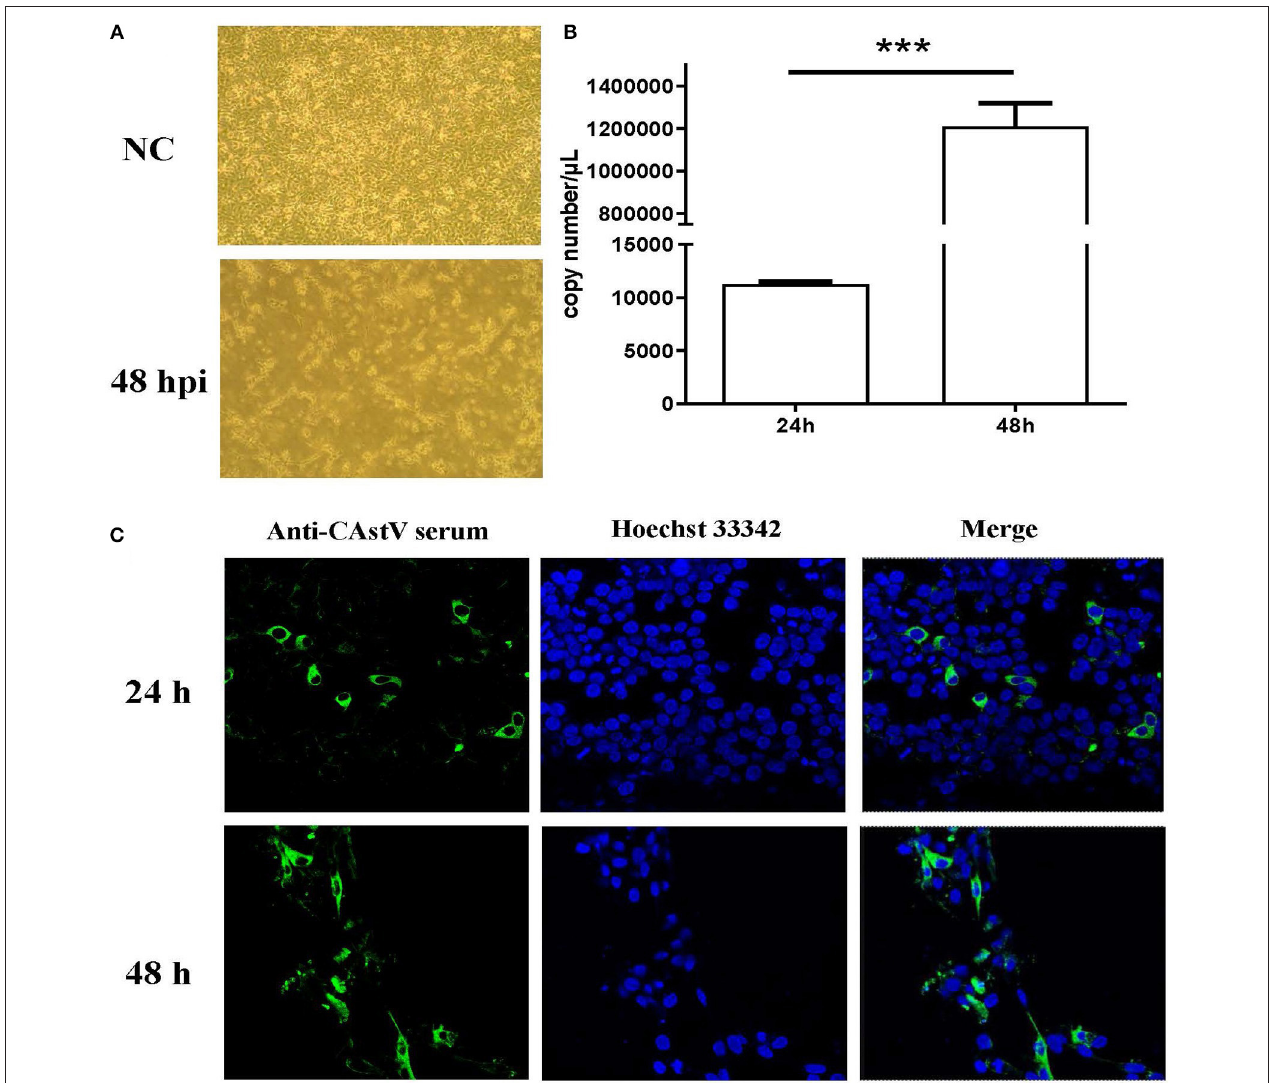
FIGURE 1 | Isolation and characterization of CAstV NJ1701 isolate in LMH cell culture. After four passages, the virus was isolated and identified in LMH cells. (A) Uninfected LMH cells at 48h post infection (p.i.) (NC, upper panel) and LMH cells infected with NJ1701 at 48h p.i. (lower panel), which are detached with small and round cells present in the media (400 × ). (B) The viral gene copy numbers in cell supernatant were 1.13 × 10 4 and 1.21 × 10 6 copies/ µ l at 24 and 48h p.i., respectively. Data were expressed as mean ± SD from three independent experiments. *** P < 0.001. (C) Indirect immunofluorescence assay was performed at 24 and 48h post-infection with mouse-anti-CAstV serum. Immunofluorescence results of CAstV show cytoplasmic staining in the infected LMH